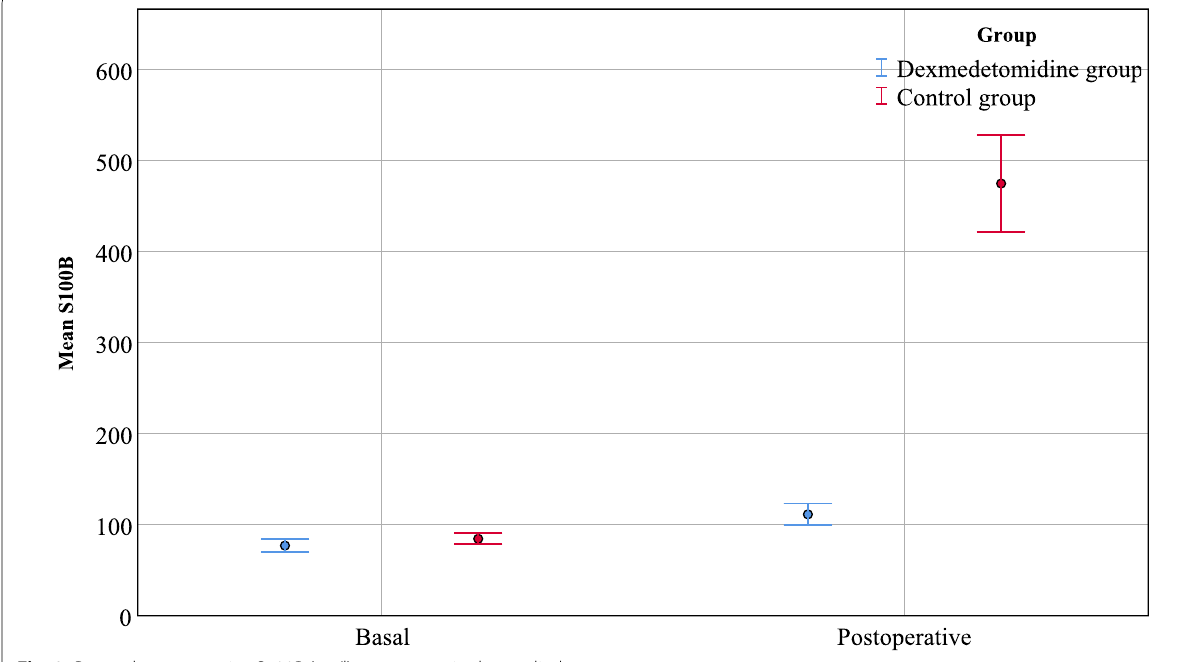
Fig. 2 Pre‑and postoperative S100B (ng/l) assessment in the studied groups